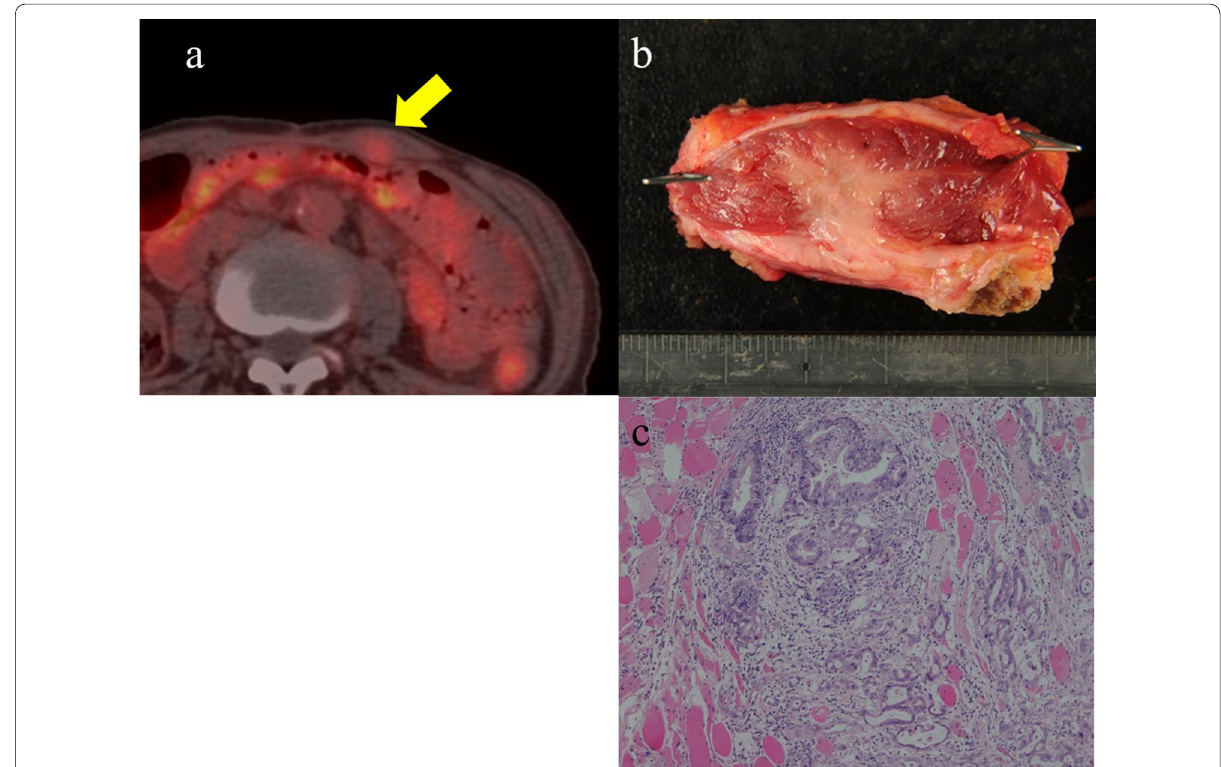
Fig. 4 Computed tomography (CT) scan and pathological findings of the second recurrence. a Positron emission tomography (PET)/CT scan showing an elevated fluorodeoxyglucose (FDG) intake in the left rectus abdominis muscle. b Macroscopic findings showing a white nodular lesion in the skeletal muscle. c Pathological examination revealing an adenocarcinoma consistent with metastatic tumor from gastric cancer